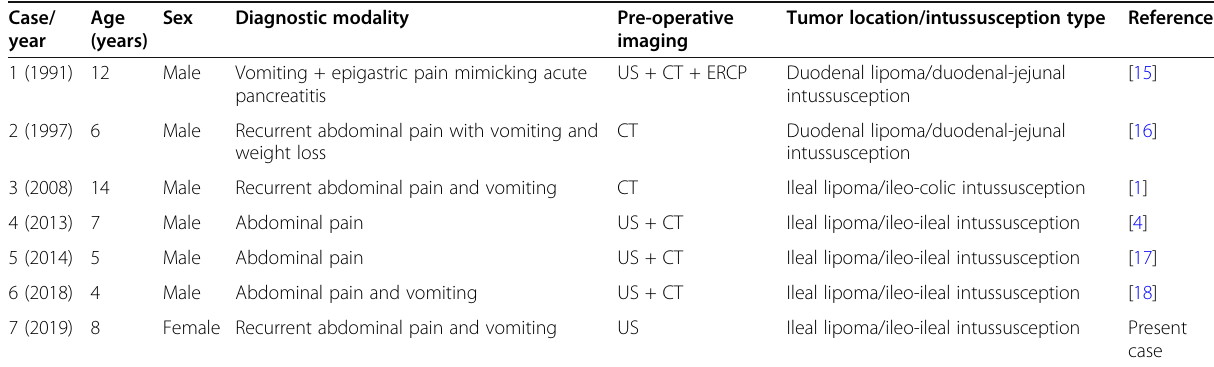
Table 1 Reported pediatric cases of small intestinal lipoma in the English